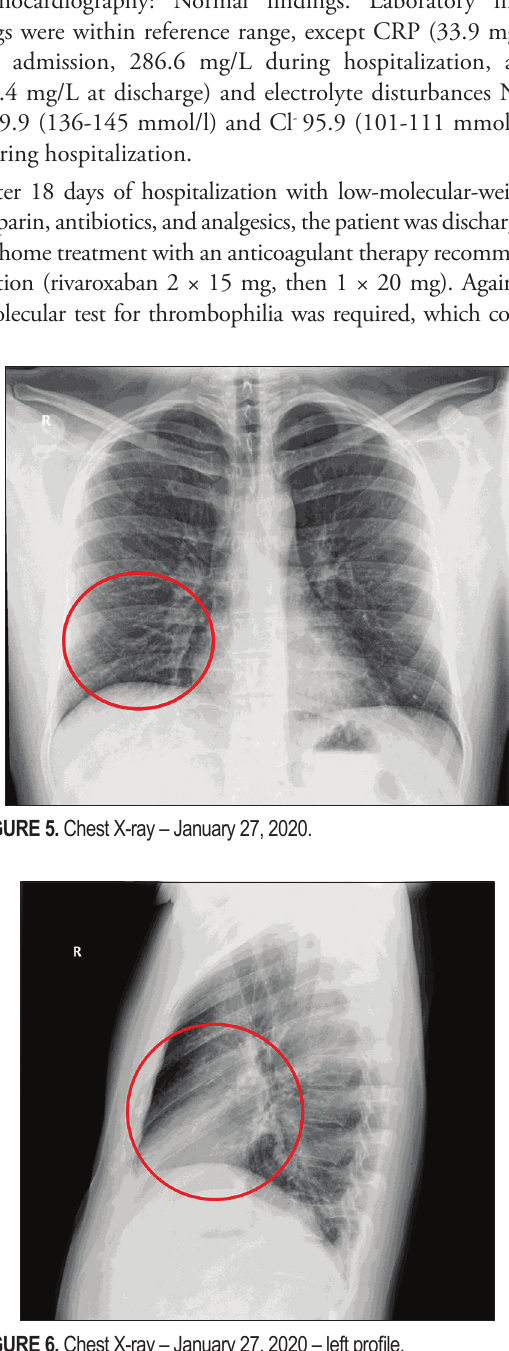
FIGURE 8. Chest X-ray – January 5, 2021.